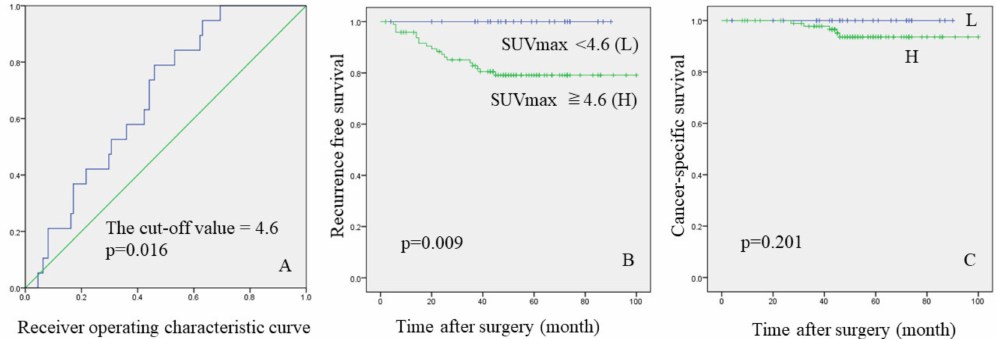
Figure 3. ( A ): the receiver operating characteristic curve for predicting cancer recurrence. Kaplan- Meier curves (( B ): recurrence free survival, ( C ): cancer-specific survival).